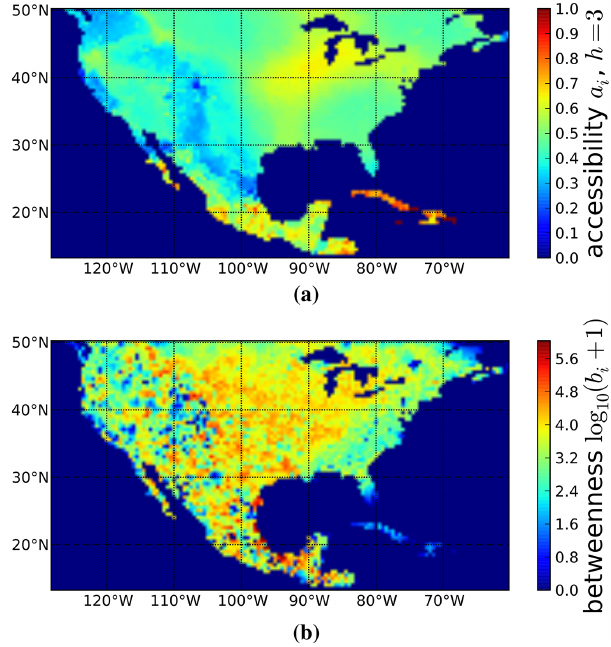
Figure 3. (a) Betweenness centrality b i and (b) accessibility a i for h = 3 steps obtained from the network of temperature